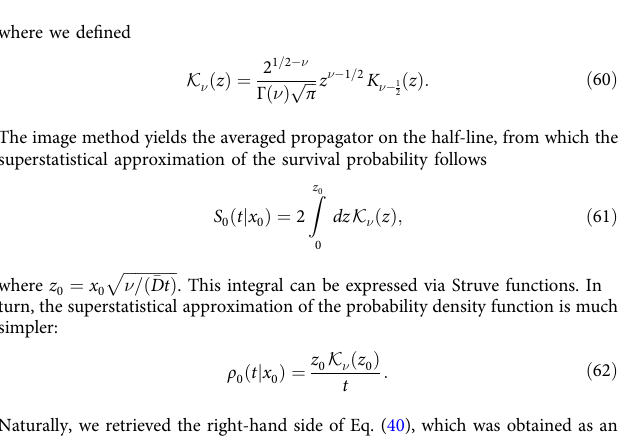
ffiffiffiffiffiffiffiffiffiffiffiffiffiffi ν = ð (cid:1) Dt Þ